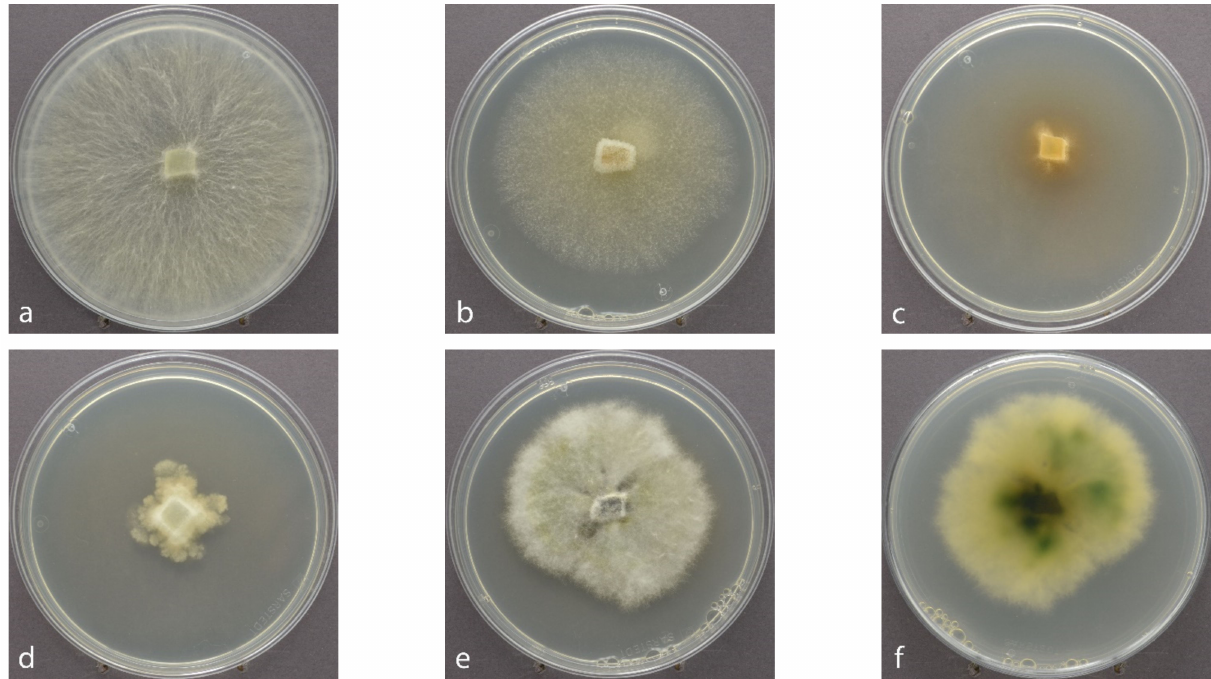
Figure 3. Endophytic Xylariales of Scots pine twigs not detected by HTS, cultivated on MYP in 90 mm Petri dishes, seven days in ambient daylight at room temperature, at around 22 ◦ C: ( a – e ) obverse, ( f ) reverse; ( a ) Biscogniauxia mediterranea ; ( b ) Biscogniauxia nummularia ; ( c ) Nemania serpens ; ( d ) Rosellinia sp.; ( e – f ) Hypoxylon fragiforme